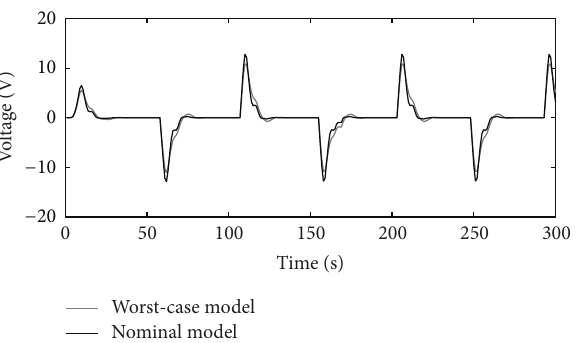
Figure 14: Input-output disturbance rejection.